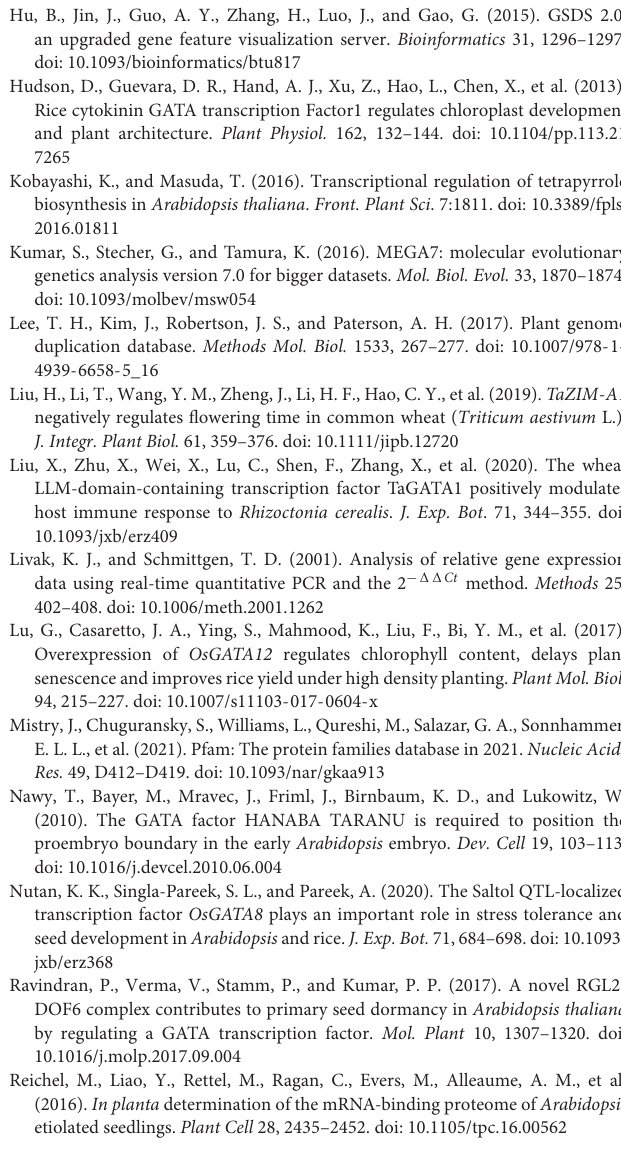
Supplementary Figure 1 | Maximum likelihood (ML) tree of GATAs in plants. The numbers of GATAs were 27 in Brachypodium , 29 in Arabidopsis , and 28 in rice, and construction was based on the full-length protein sequences. Four subgroups of GATAs were classified as I, II, III, and